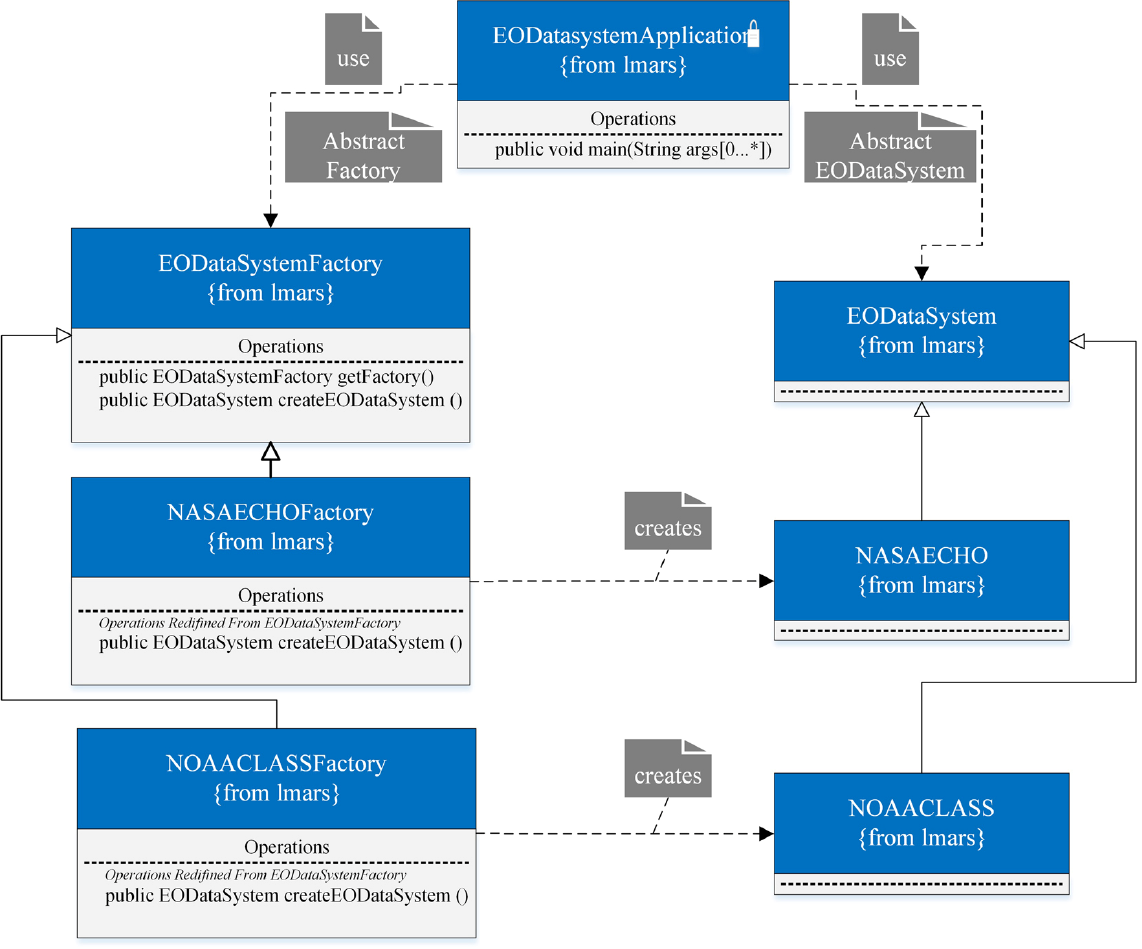
Figure 4. Abstract factory implementation of an EO data system